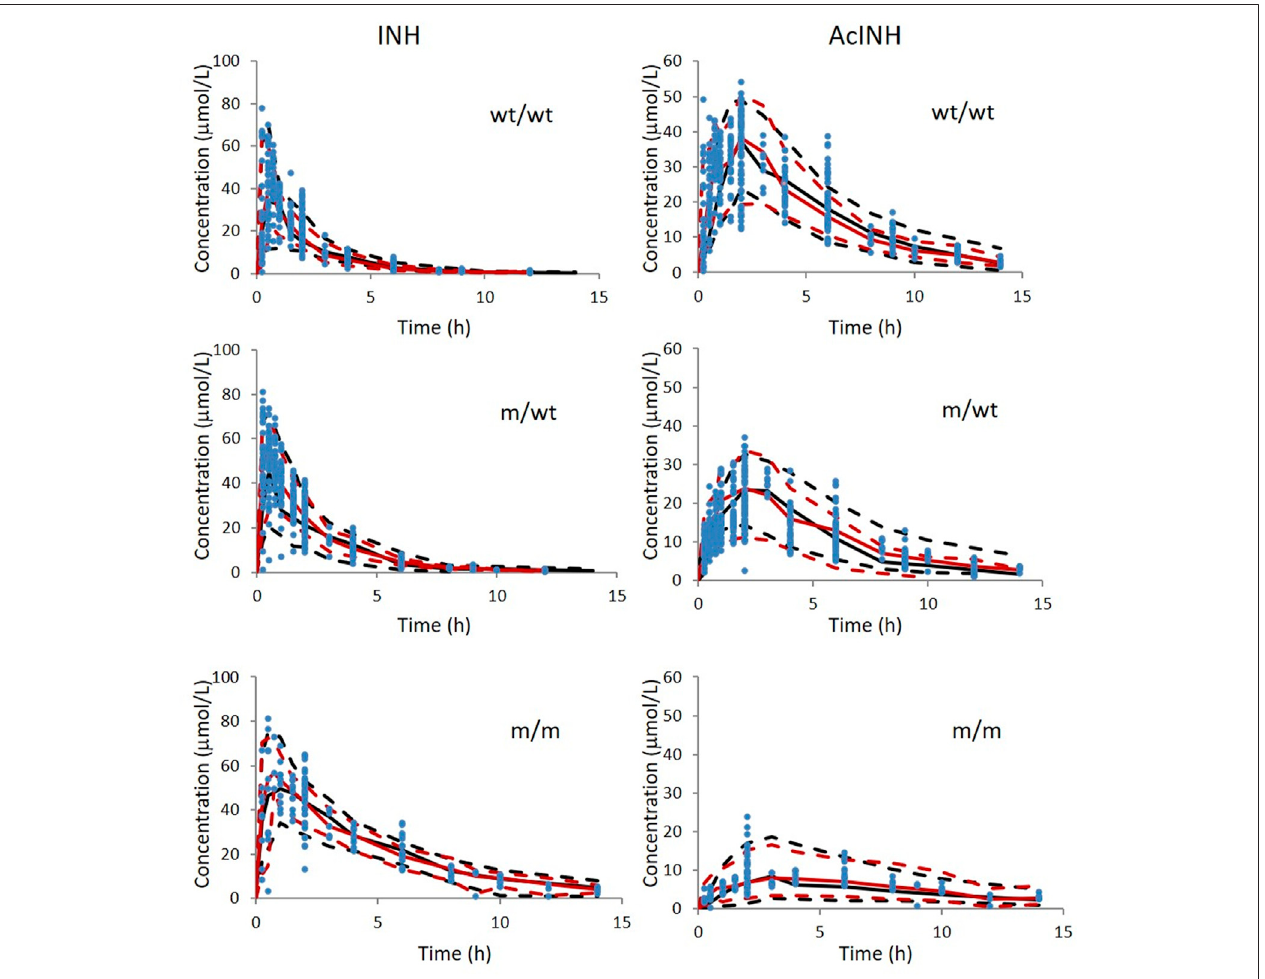
FIGURE 4 | Visual predictive check of INH and AcINH based on the integrated PPK model in Chinese healthy subjects and tuberculosis patients with therapy of INH. The red and black sold lines represent 50th of observed data and simulated data; The upper and lower red dashed lines represent 95th and 5th of observed data; The upper and lower black dashed lines represent 95th and 5th of the simulated data. The blue solid cycles represent observed data wt/wt: NAT2 homogenous wild type; m/wt: NAT2 heterozygous mutant genotype; m/m: homogenous mutant genotype.